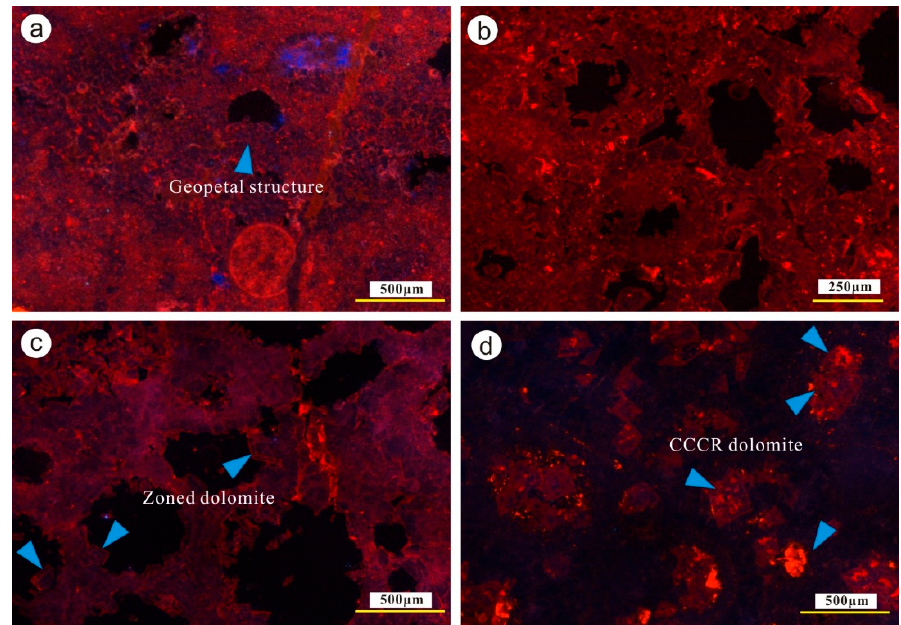
Figure 4. Cathodoluminescence characteristics of dolomite from the Yudongzi outcrop. ( a ) Banded marly microcrystalline tidal flat dolomite with dark red luminescence and geopetal structures, sample YA-80. ( b ) Residual oolitic dolomite from the platform-margin oolitic beach facies with orange-red luminescence, sample YA-84. ( c ) Residual oolitic dolomite from the platform-margin oolitic beach facies with an annulus of dark red luminescence, sample YA-B-12. ( d ) CCCR gray dolomite in the platform-margin oolitic beach facies with cloudy cores in bright orange-red and clear rims with dark or absent luminescence, sample YA-74.